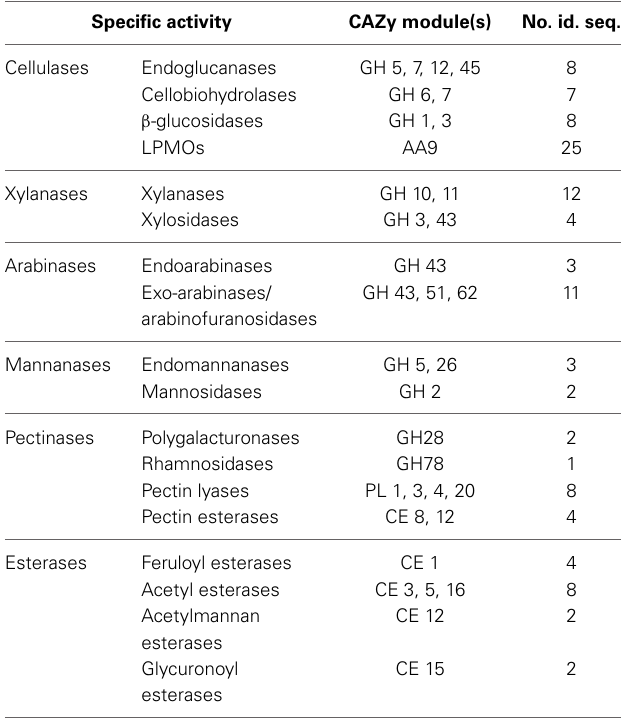
Table 1 | Number of predicted CAZymes encoded in the genome of M. thermophila